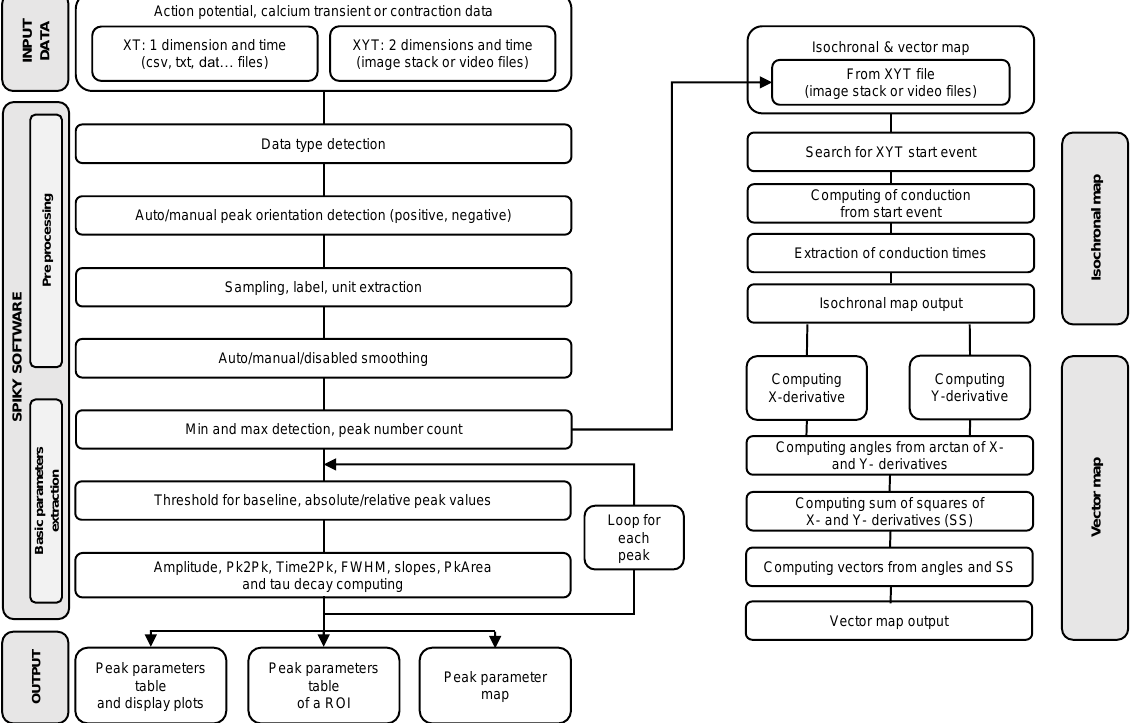
Figure 1. Flow diagram of the Spiky algorithm. Pk2Pk, Time2Pk, FWHM and PkArea correspond respectively to the parameters peak to peak, time to peak, full width at half maximum and area of the